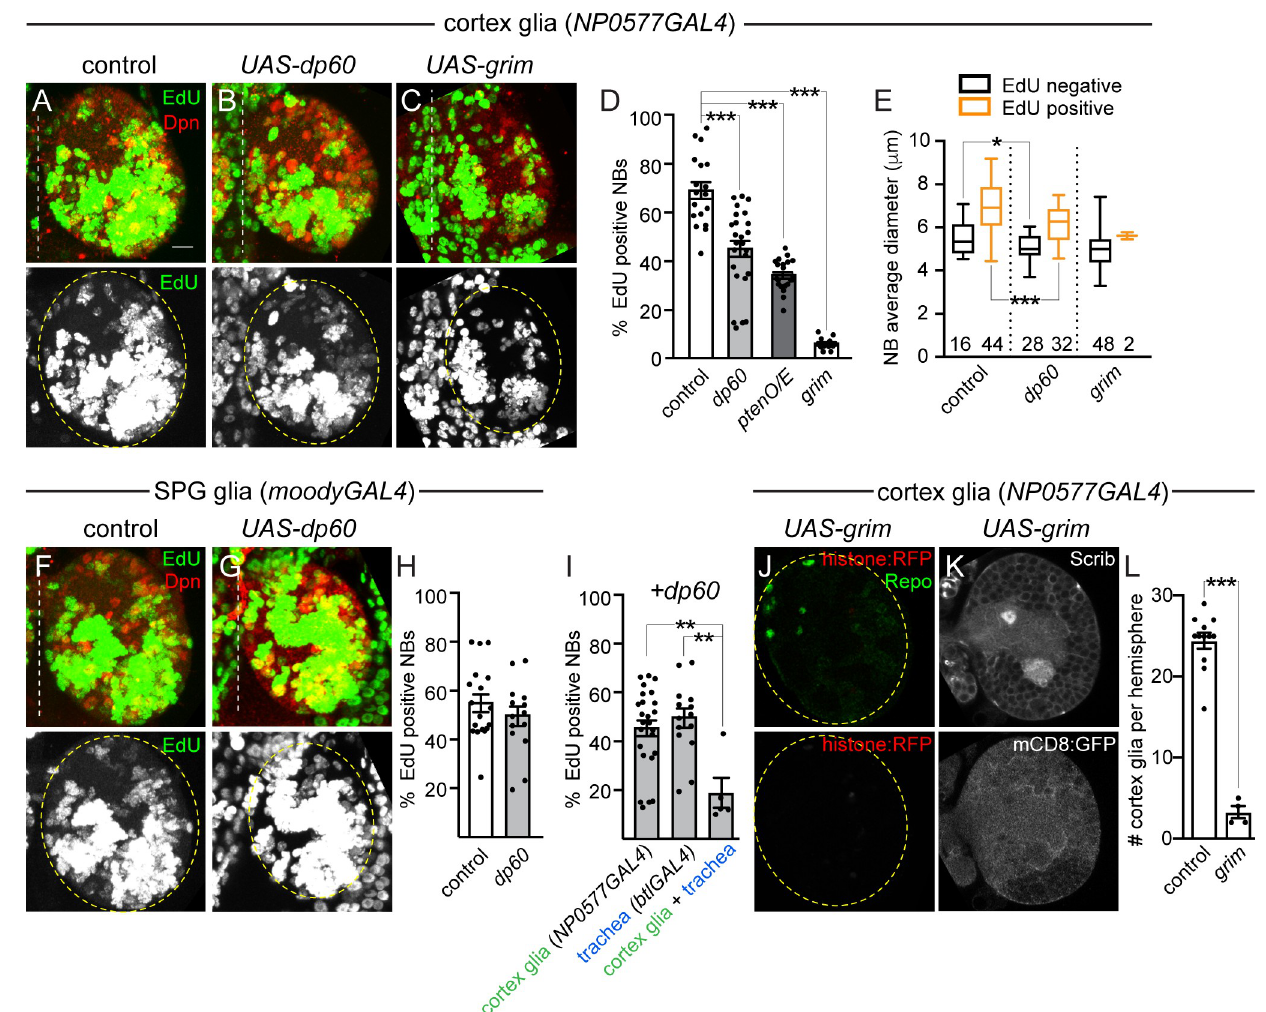
Fig 4. Cortex glia are required for nutrient-dependent NB reactivation from quiescence. (A–D) EdU-positive NBs in animals with genetic manipulations in cortex glia at 24 hours after feeding. (A–C) Maximum intensity projections of brain hemispheres. Top panels are colored overlays, and bottom panels show single-channel grayscale images. Brain hemispheres are outlined, and the dotted vertical lines indicate the midline. Graphs show quantification of EdU-positive NBs per brain hemisphere (D) and NB size based on EdU incorporation (E). Numbers in E indicate the number of NBs analyzed. (F–H) EdU-positive NBs in animals with genetic manipulations in SPG and neuropil glia at 24 hours after feeding. (F–G) Maximum intensity projections of brain hemispheres. Panels are colored overlays (top), with single-channel grayscale images below. Brain hemispheres are outlined, and dotted vertical lines indicate the midline. Quantification of EdU-positive NBs per brain hemisphere (H). (I) Quantification of EdU-positive NBs per brain hemisphere of indicated genotypes. (J) Single Z-plane image, top panel is a colored overlay with single-channel grayscale image below, brain hemisphere outlined. (K) Two (top and bottom) grayscale images of same Z-plane, with quantification of cortex glia number following genetic ablation quantified in (L). (D,I) One-way ANOVA with Tukey post hoc analysis and (E,H,L) Student two-tailed t test, � p < 0.05, �� p < 0.01, ��� p < 0.001. Genotypes of panels listed in S2 Table and data listed in S1 Data. btl , breathless ; Dpn, Deadpan; dp60 , Drosophila protein 60 ; EdU, 5-ethynyl-2 0 -deoxyuridine; mCD8, membrane-targeted CD8 antigen; NB, neuroblast; O/E, overexpression; Pten, phosphatase and tensin homolog; Repo, reversed polarity; RFP , red fluorescent protein; Scrib, Scribble; SPG, subperineurial glia; UAS , upstream activating